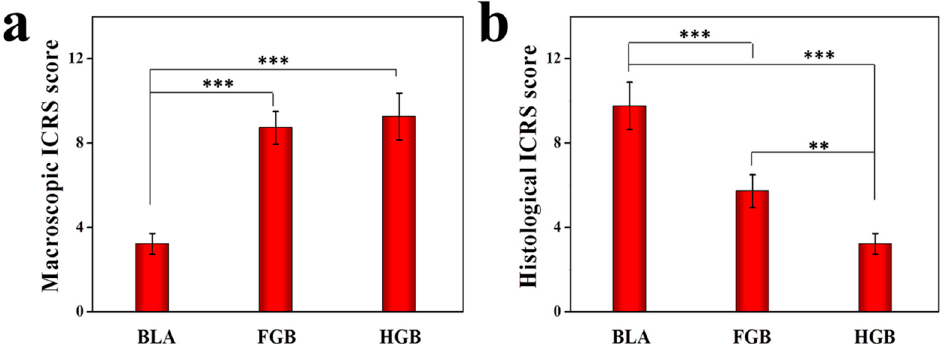
Figure 8. ( a ) Macroscopic ICRS scores and ( b ) histological ICRS scores of microscopic observation in BLA, FGB, and HGB groups. The results are representative of means ± SD ( n = 5, ** p < 0.01, *** p <